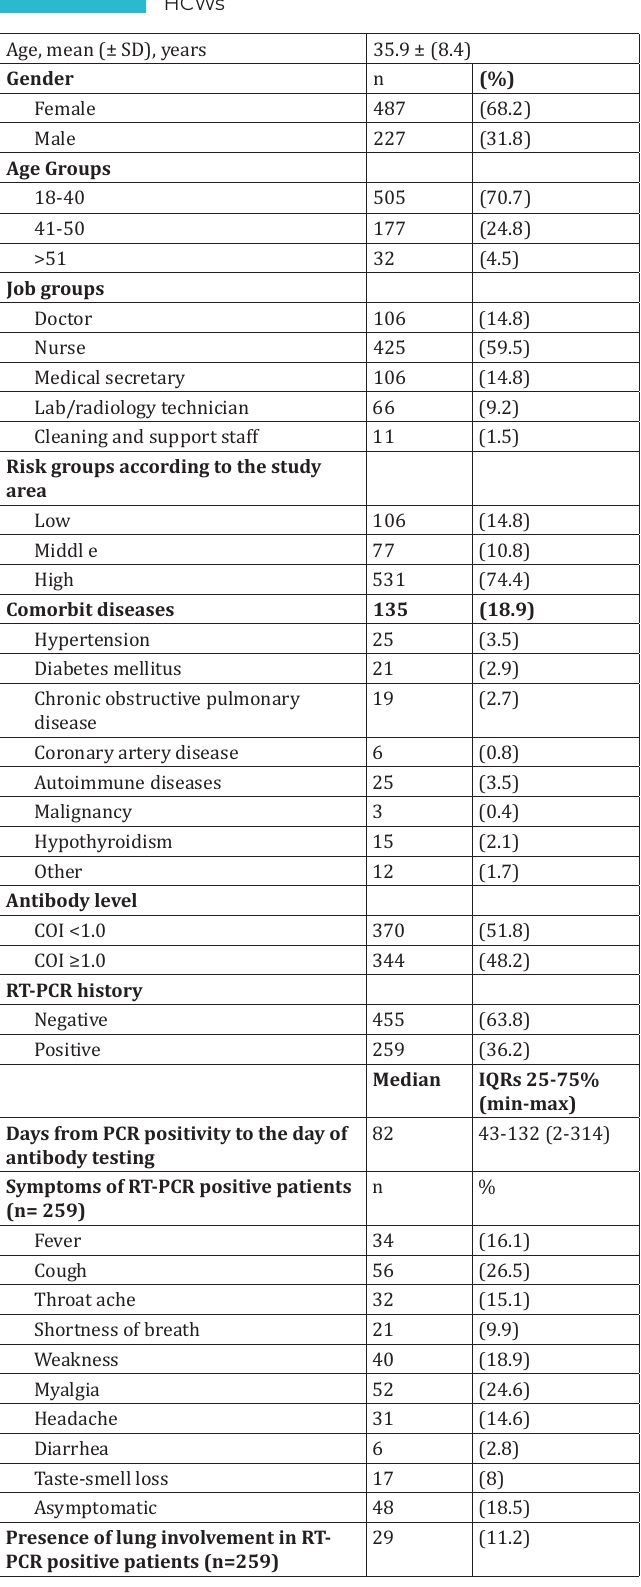
Demographic and Clinical Characteristics of